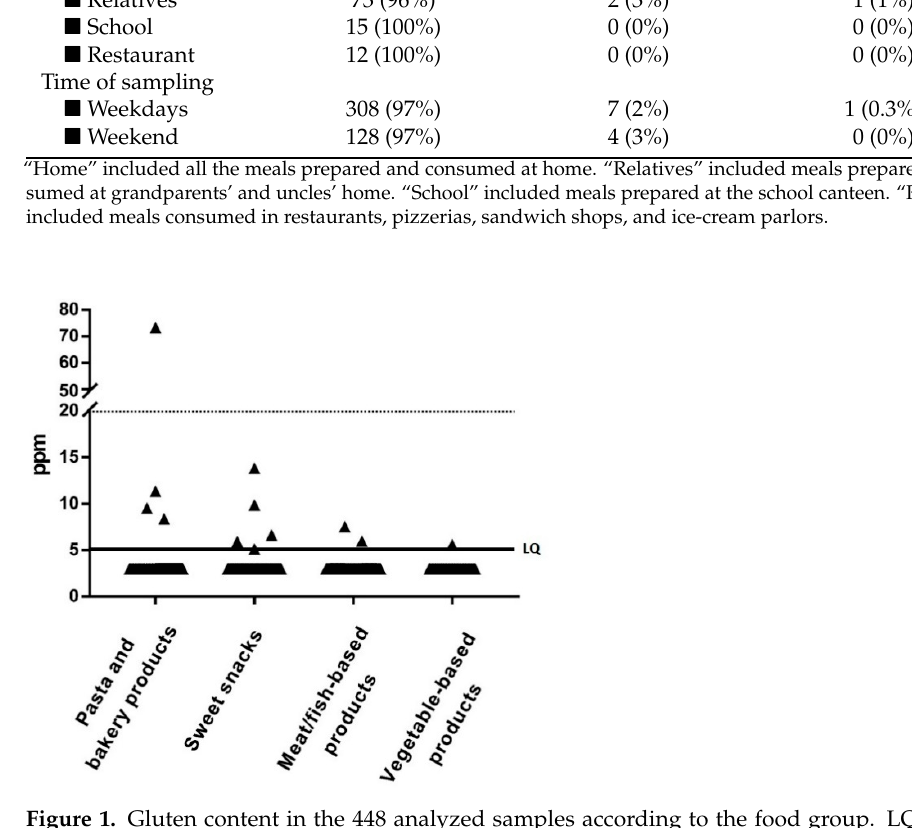
Table 2. Gluten contamination level according to food samples features.